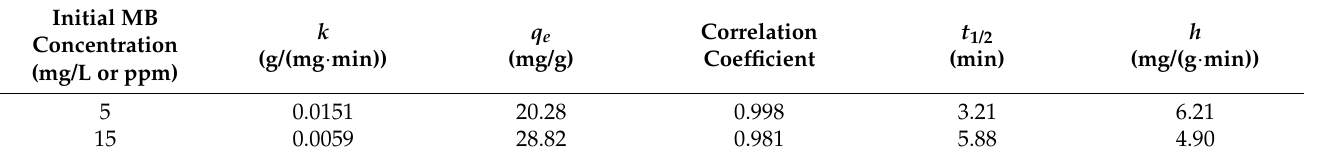
Figure 7. Variations of dimensionless MB concentrations (C t /C 0 ) with adsorption times under various initial MB concentrations (i.e., PP-BC-900-20 dosage: 0.3 g/2 L, initial pH: 7.0, adsorption temperature: 25 °C); the symbols denote experimental data, and the full lines were obtained from the pseudo-second-order model using the fitted parameters (Table 3). Table 3. Pseudo-second-order model parameters for MB adsorption onto PP-BC-900-20 at various initial MB concentrations ( a